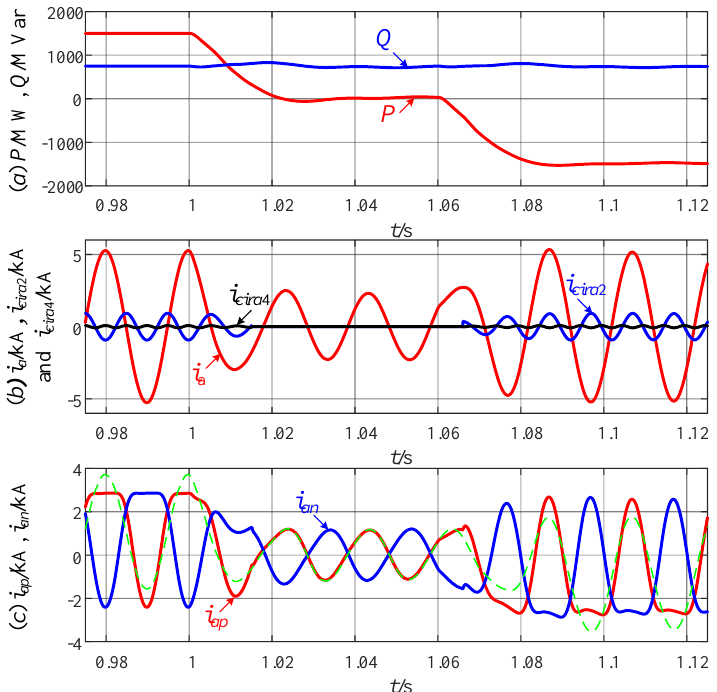
Figure 10. Simulation waveforms of the MMC considering switching processing.